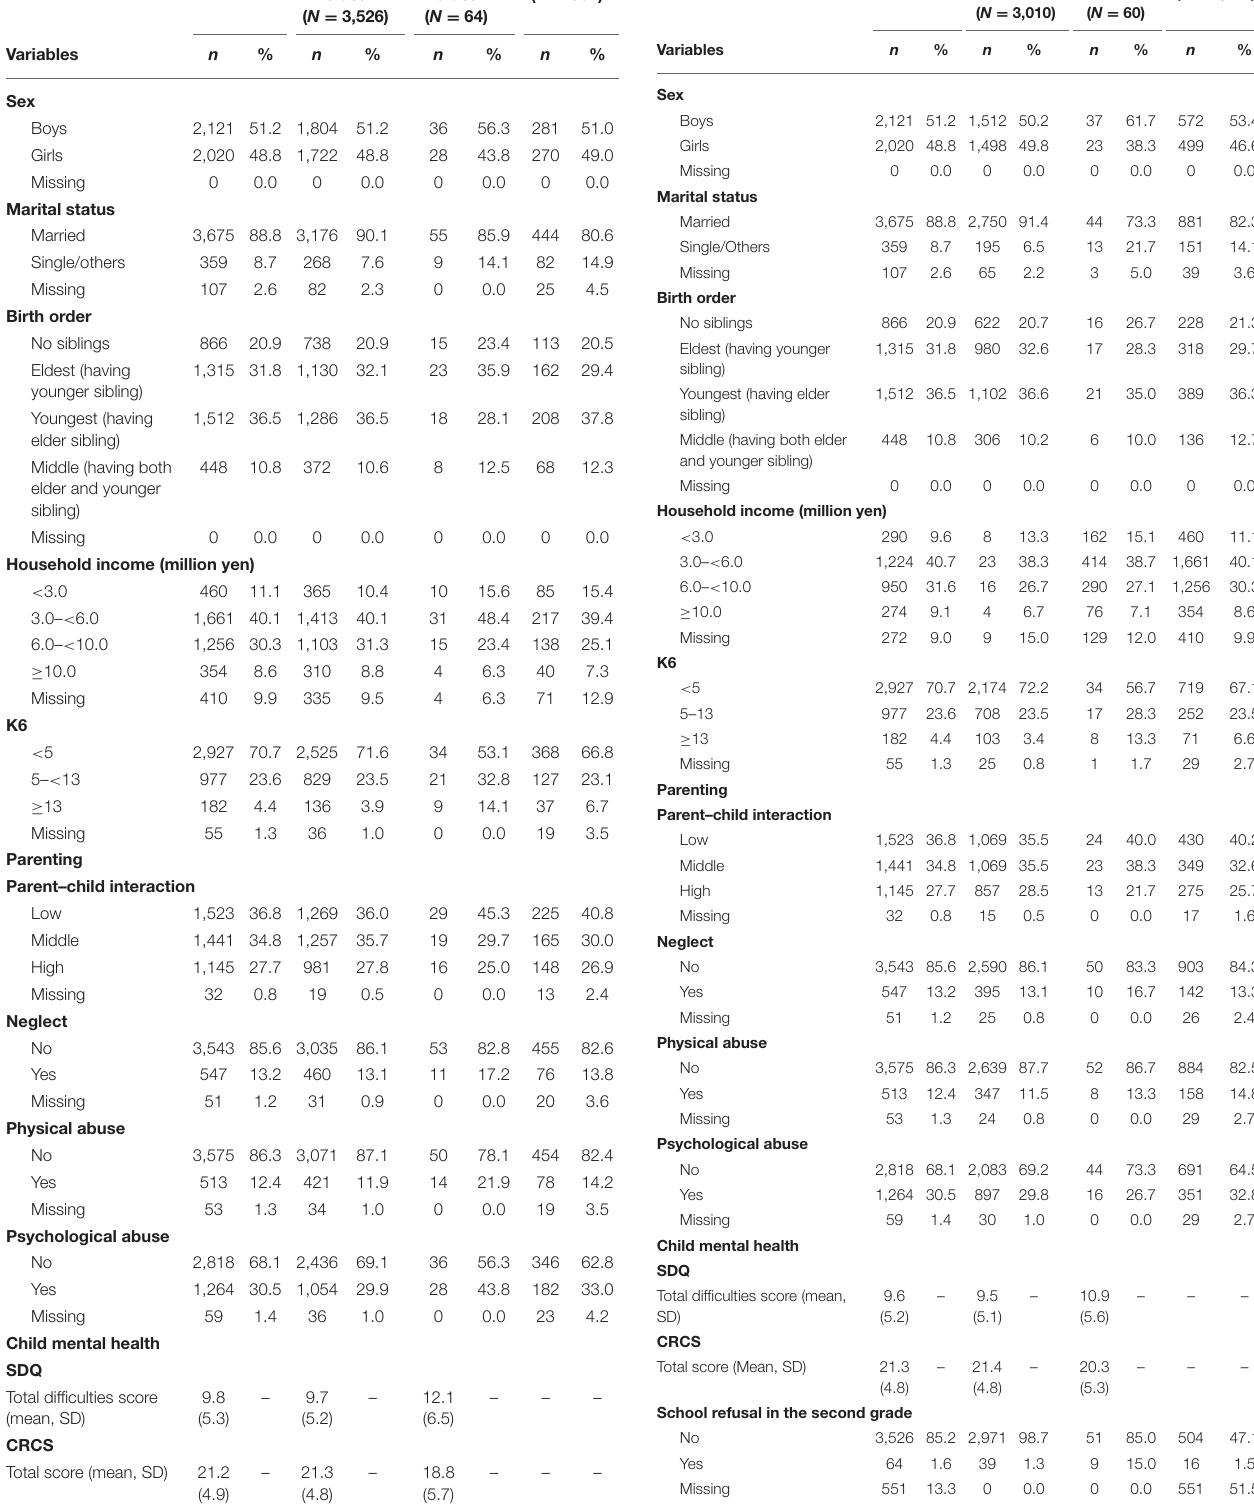
Total No school refusal ( N =